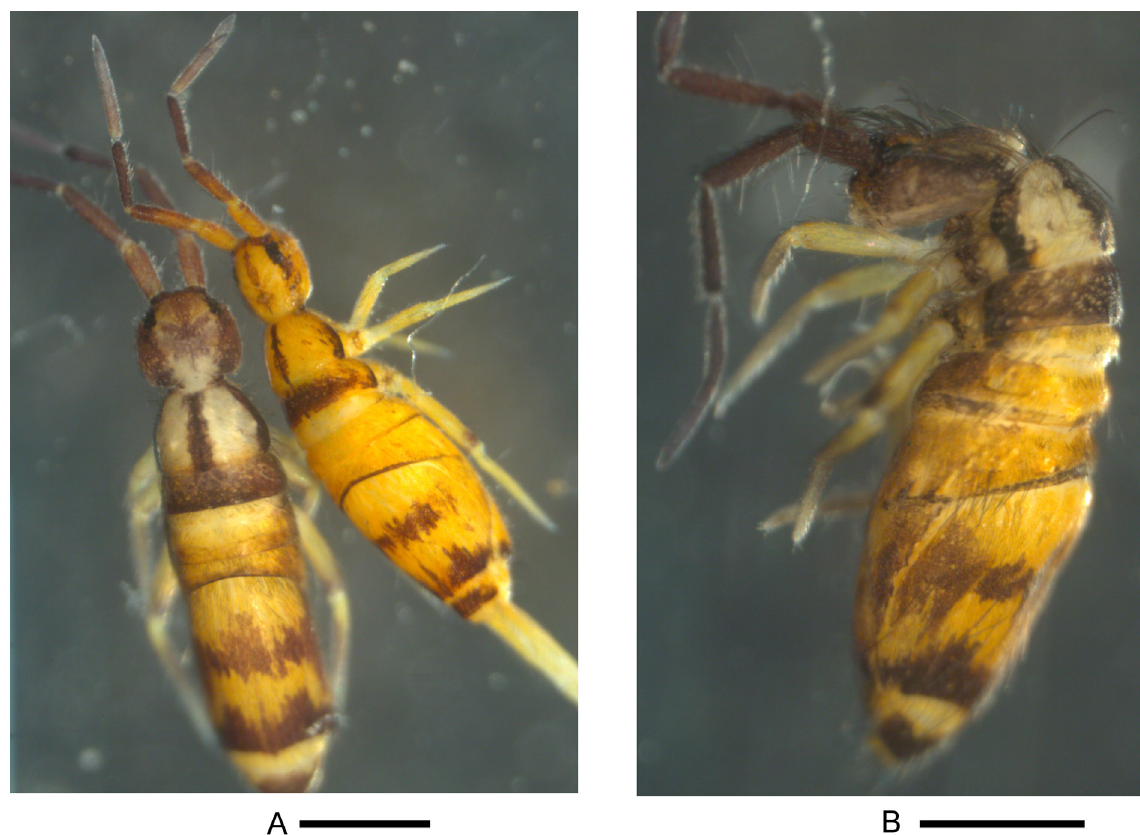
Fig. 1. Entomobrya leviseta sp. nov. A–B . Habitus. Scales bars: A–B = 500 μm.